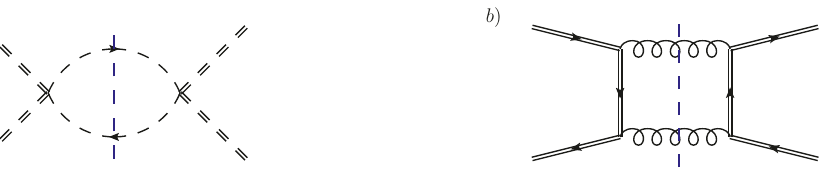
Figure 1 . One-loop diagrams for DM pair (double-dashed lines) annihilations into SM Higgs bosons (dashed lines) and F (cid:22) F (double-solid lines) annihilations into a gluon pair (curly lines). The blue dashed line implements a cut along the light particles into which the heavy ones